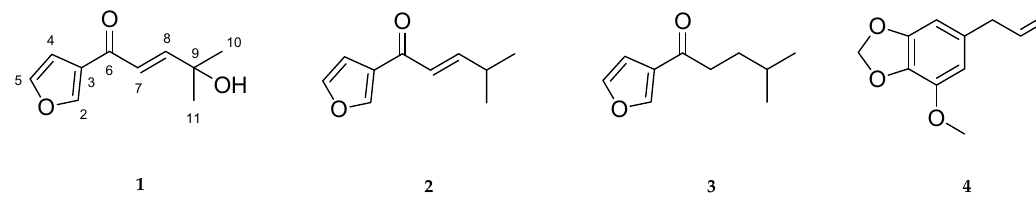
Figure 1. Perilla frutescens var. crispa (Lamiaceae): ( a ) A mutant cultivar, P. frutescens var. crispa (cv. Antisperill; PFCA), which developed by 200 Gy gamma irradiation from a labeled Cobalt ( 60 Co) source on seeds of an original cultivar; ( b ) an original cultivar (PFC) that has red-purple leaves.